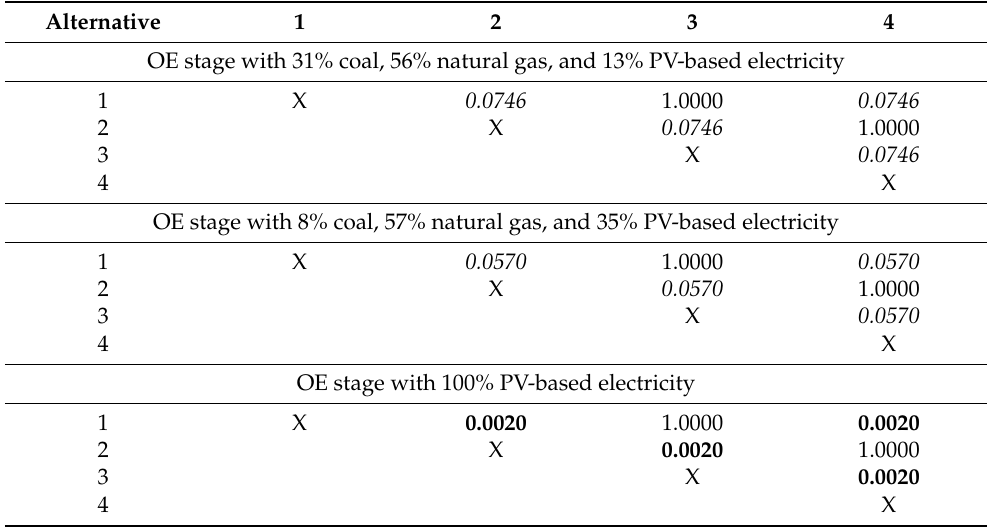
Table 7. OE stage: p -values of paired differences of CB MinWin (1), CB MaxWin (2), AAB MinWin (3), and AAB MaxWin (4).